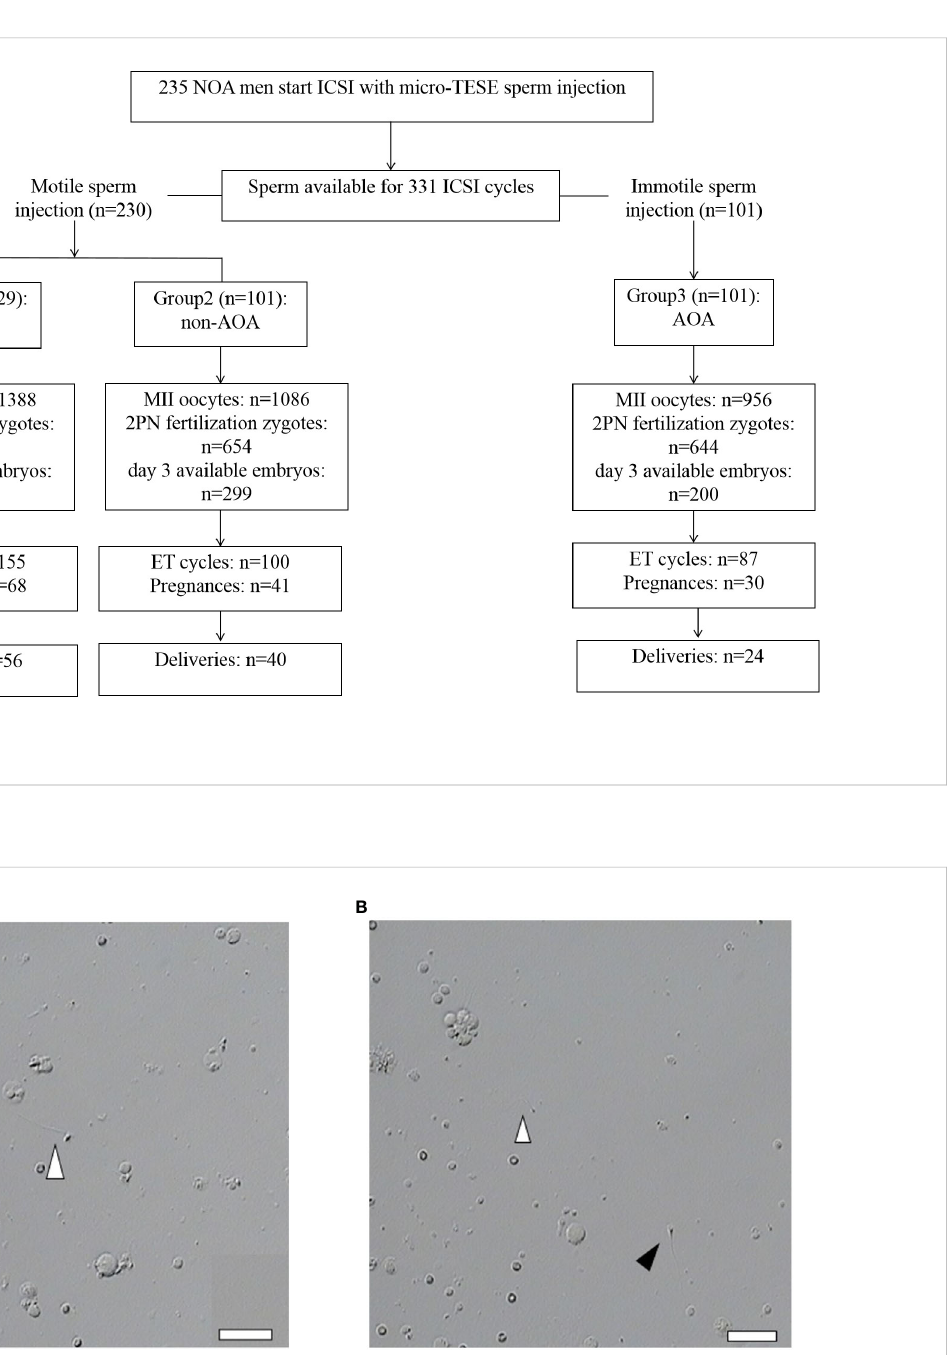
FIGURE 2 Abnormal morphology of sperm retrieved by micro-TESE. (A, B) Most of the sperm retrieved by micro-TESE are teratogenic, but occasionally normal sperm can be found. Open arrowhead indicates teratospermia. Solid arrowhead indicates normal morphology sperm (Scale bar, 20 m